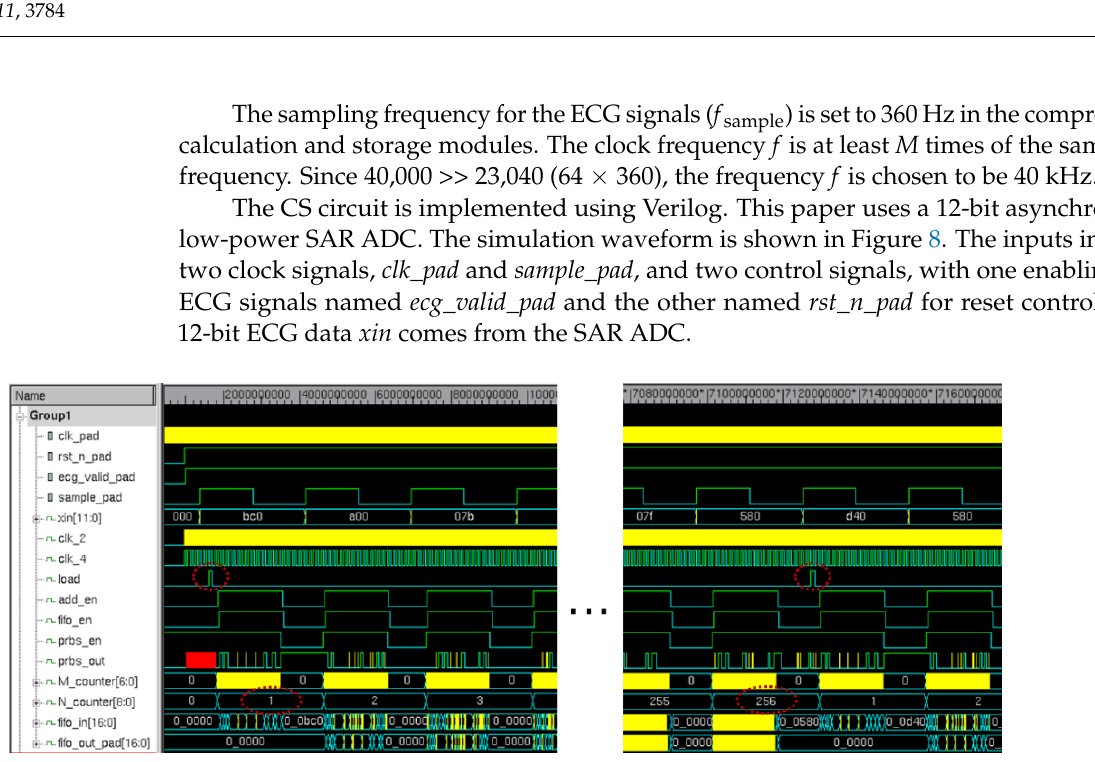
Figure 8. Waveforms of CS circuit.